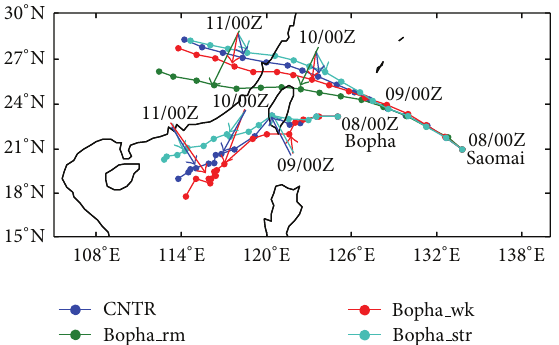
Figure 4: Simulated tracks of all sensitivity experiments at the 6-